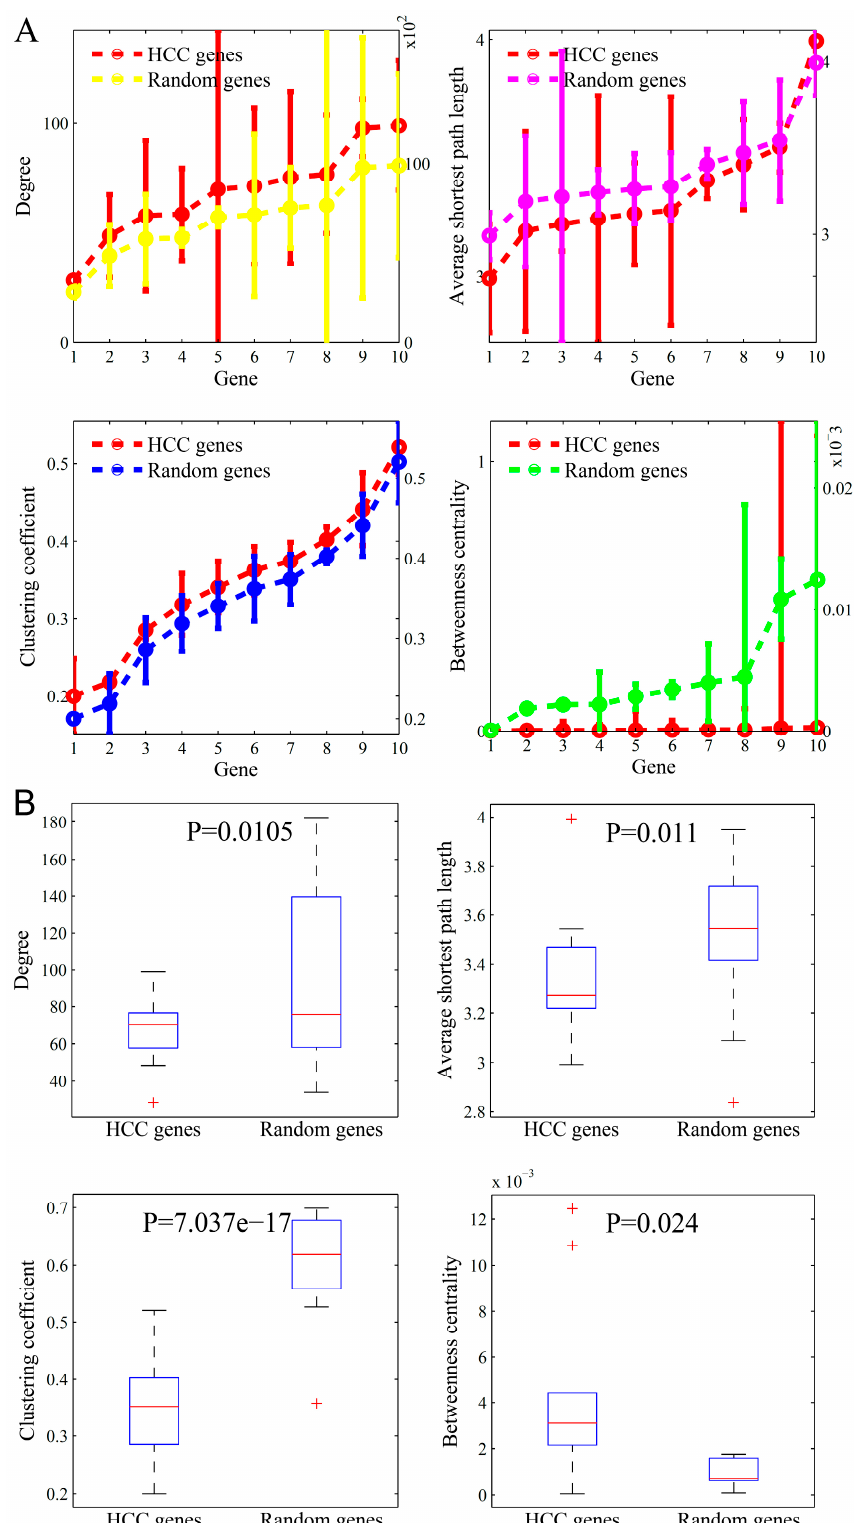
Figure 8. The comparison of topological parameters between HCC (hepatocellular carcinoma) genes and randomly-selected genes. ( A ) The means (left y-axis) and standard deviations (right y-axis) of the four parameters in the ten AD (Alzheimer’s disease) gene groups and those corresponding in the randomly-selected ten gene groups. ( B ) Boxplots of these parameters.